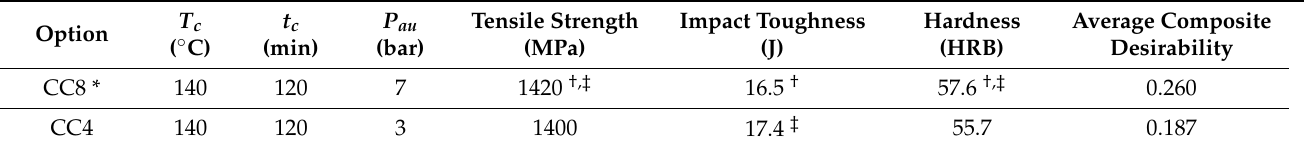
Table 8. Composite desirability function value for two options of